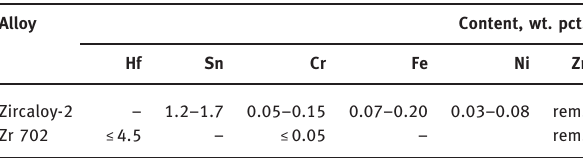
Table 1: The chemical composition of tested materials (according to standards). Alloy Content, wt. pct. Hf Sn